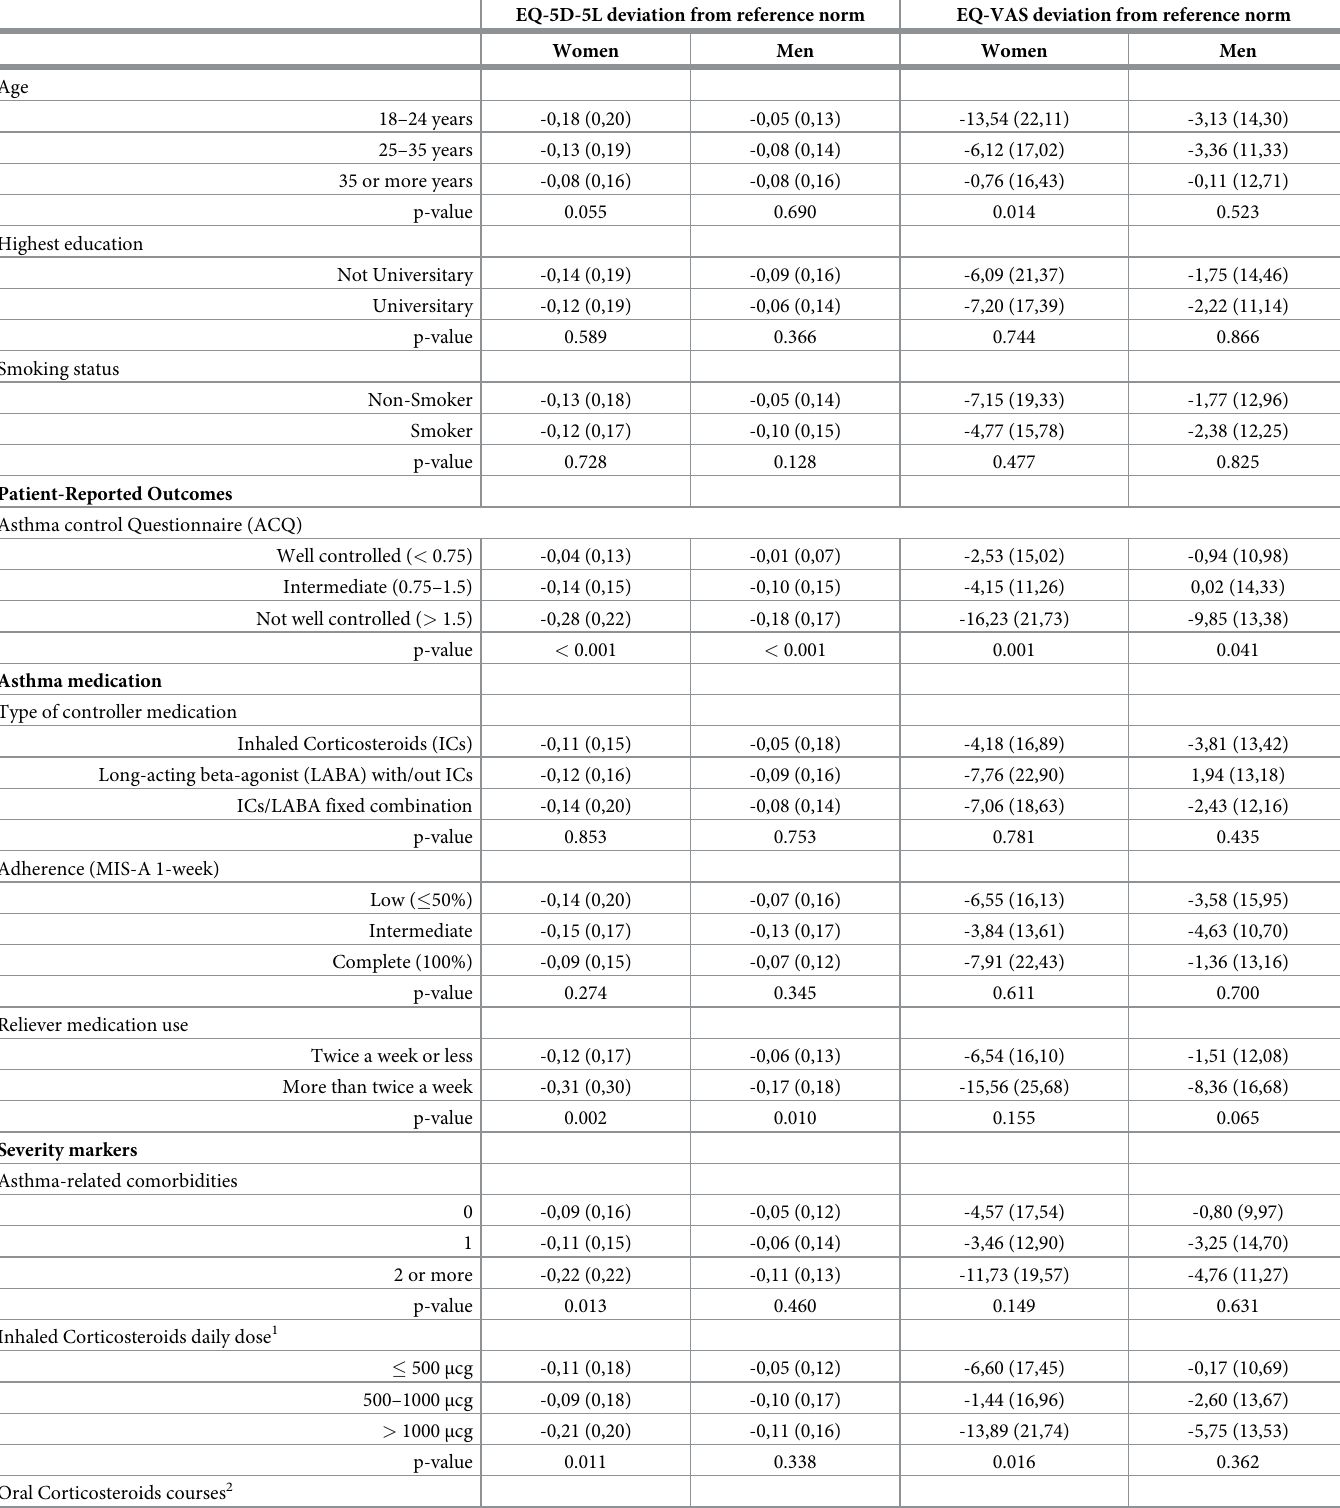
Table 2. Mean (SD) of deviations from reference norms: EQ-5D-5L index and